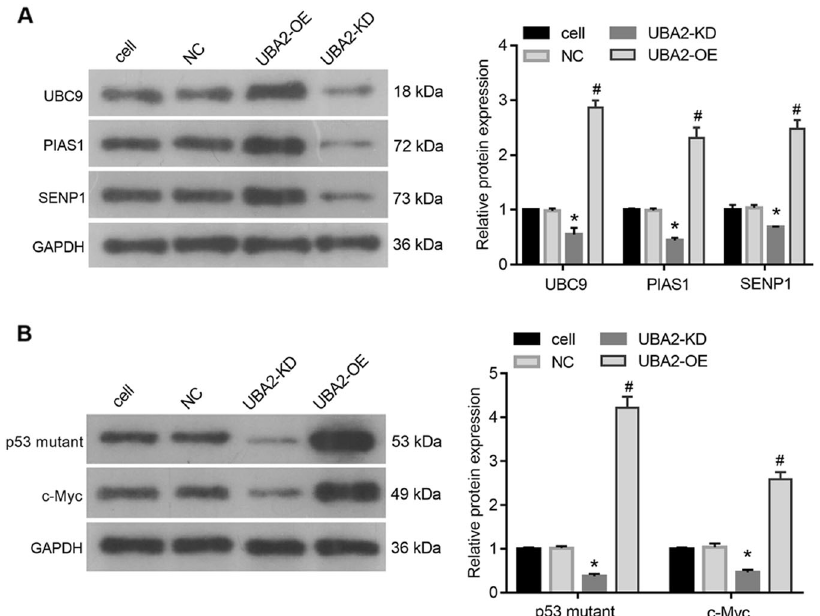
Fig. 3 Effects of UBA2 expression levels in 786-O cells on those of the p53 mutant, c-Myc, and key enzymes of the SUMO modi fi cation system. A Expression levels of the key enzymes of the SUMO modi fi cation system in four groups of cells. B Expression levels of the p53 mutant and c-Myc in four groups of cells. OE overexpression, KD knockdown, NC negative